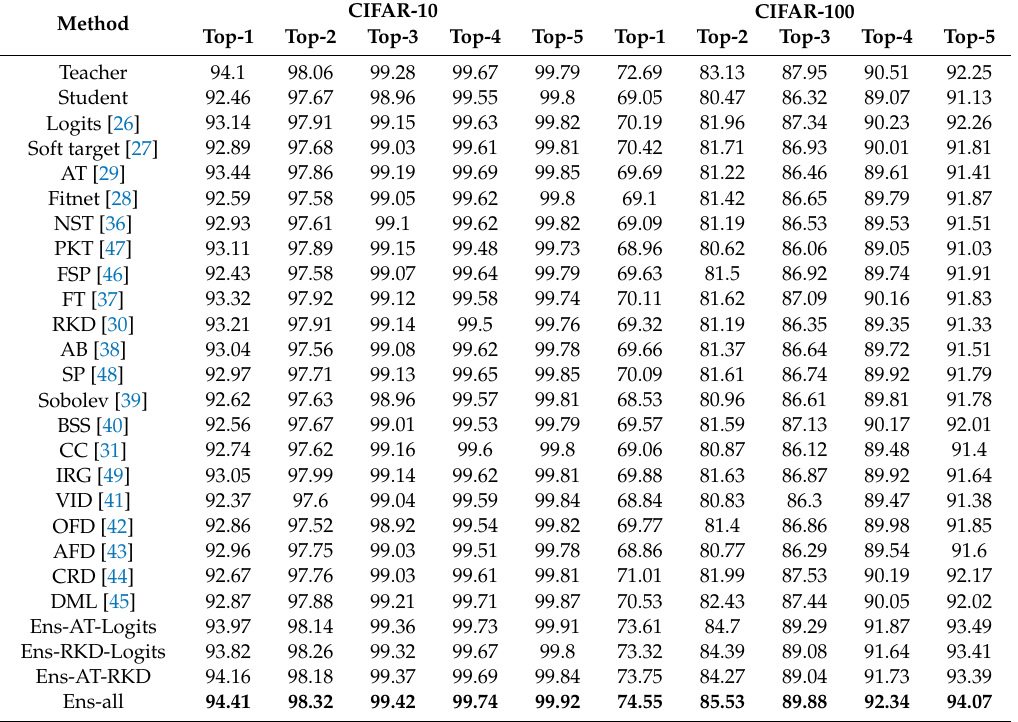
Table A1. CIFAR-10 and CIFAR-100 datasets. ( k = 1~5 on both CIFAR-10 and CIFAR-100 where k is the number of top elements to look at for computing